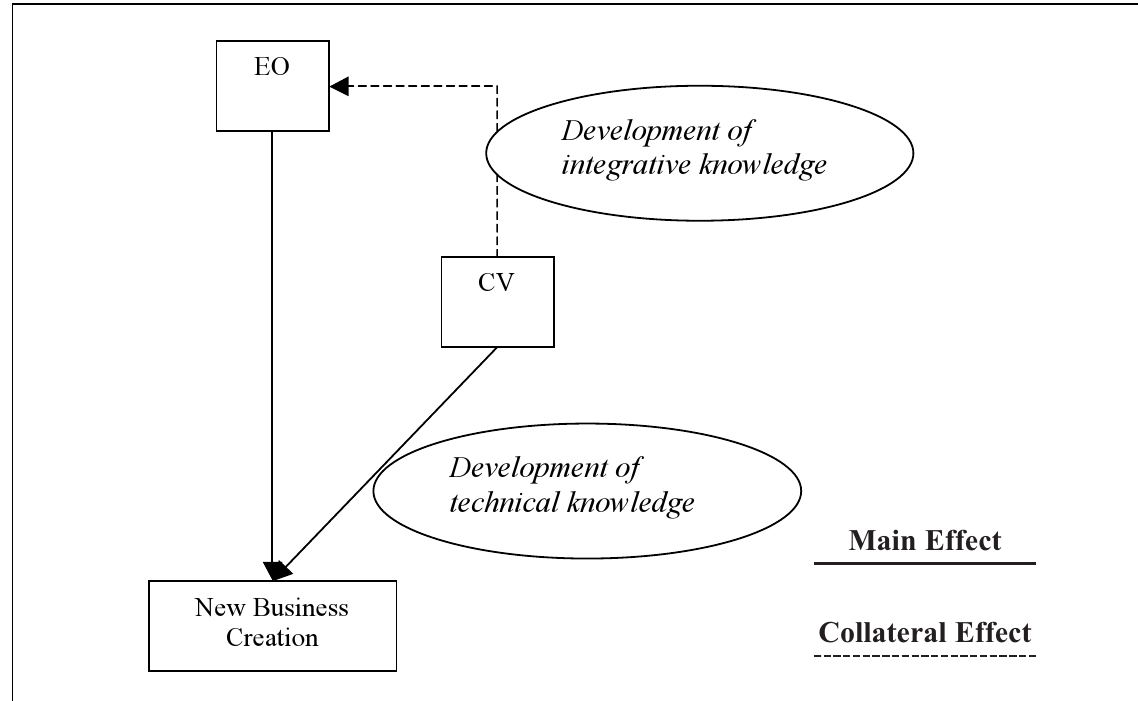
Figure 2. Effects of Corporate Venturing on New Business Creation and Entrepreneurial Orientation as Learning Processes (Personal